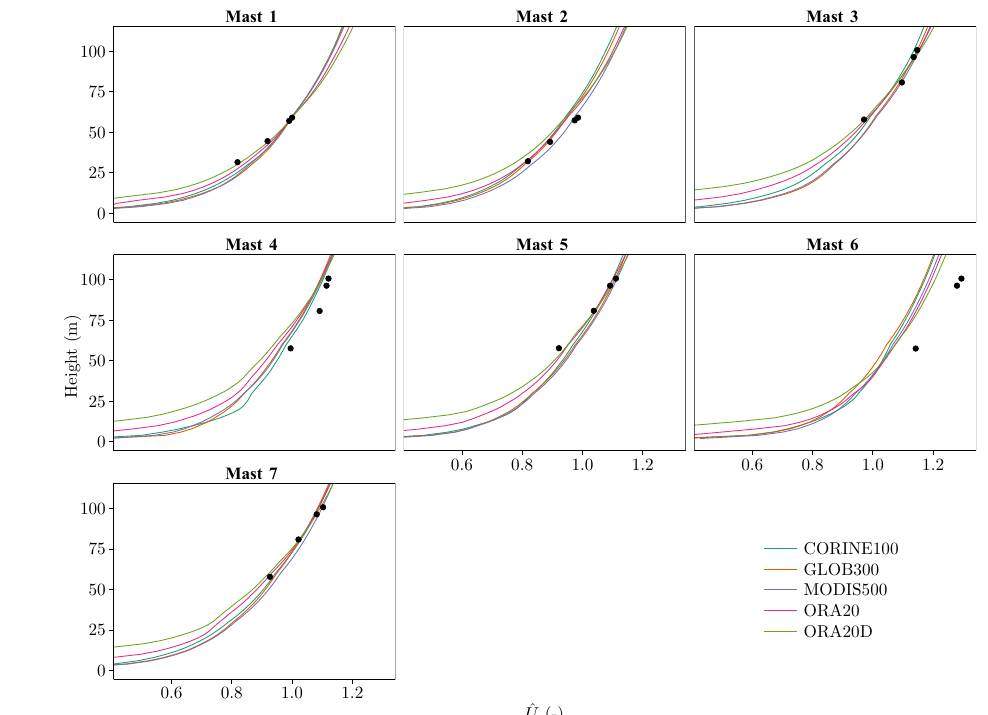
Figure 5. The all-sector modelled mean wind profile (lines) and the observations (points) at the seven masts. All the profiles were obtained by using the observed wind climate from mast 1 at 59.0m and have been normalized by the mean wind speed observed there.